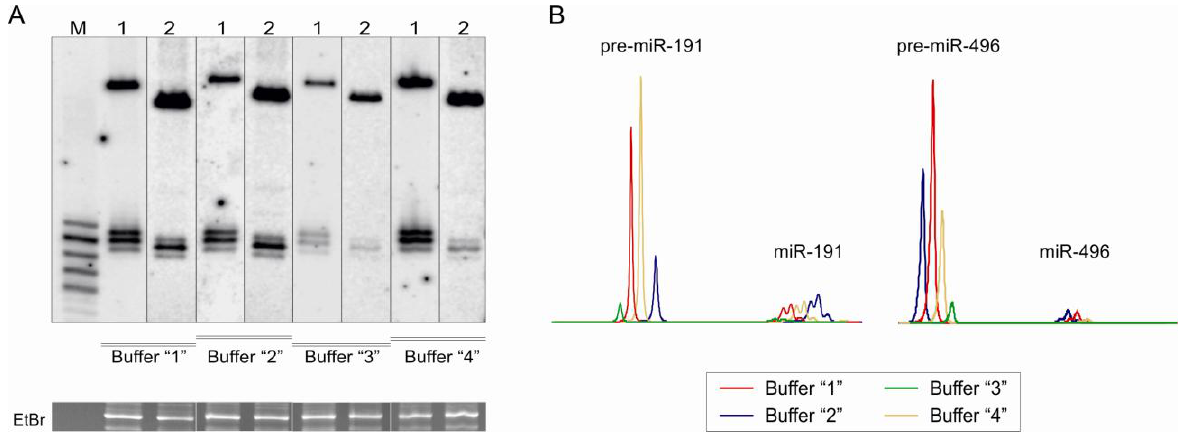
FIGURE 5. Hybridization conditions: choice of buffer. (A) Hybridizations with probes complementary to miR-191 (lanes 1) and miR-496 (lanes 2) in different buffer conditions as indicated in the figure (see buffer composition in Reagent Setup ). M denotes a size marker; end-labeled 17-, 19-, 21-, 23-, and 25-nt ORNs. Staining with ethidium bromide (EtBr) provides a loading control. (B) Quantitative representations of the miRNA and pre-miRNA length variants obtained from phosphorimaging